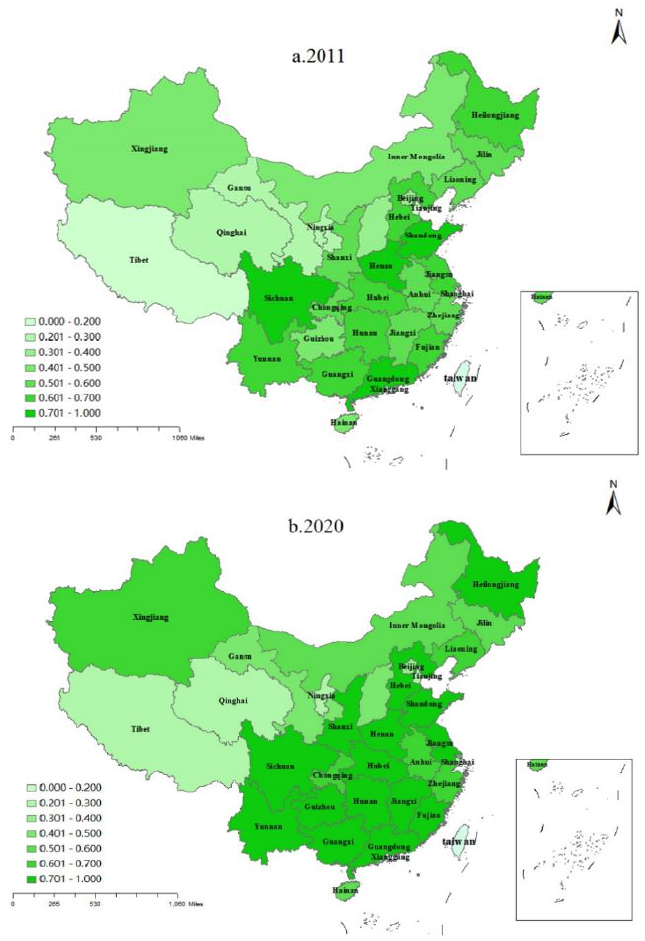
Figure 2. Heat map of coupling coordination between agricultural economy and environment .